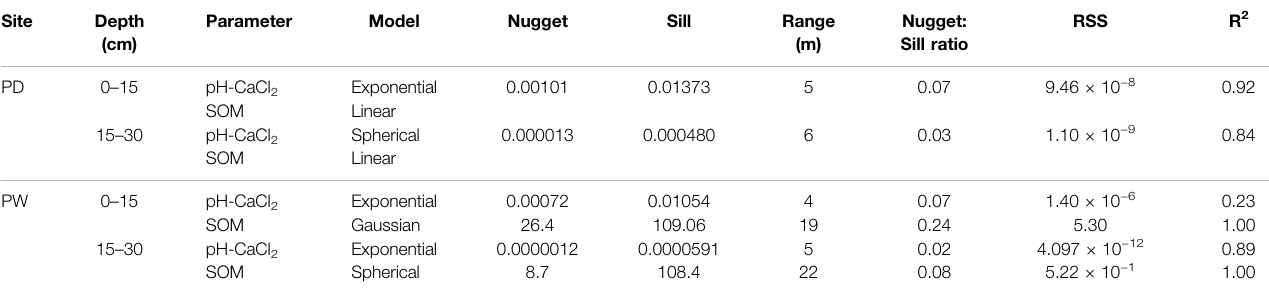
TABLE 5 | Spatial dependence of soil pH and organic matter in the surface and subsurface horizons of the rewetted and drained peatlands.